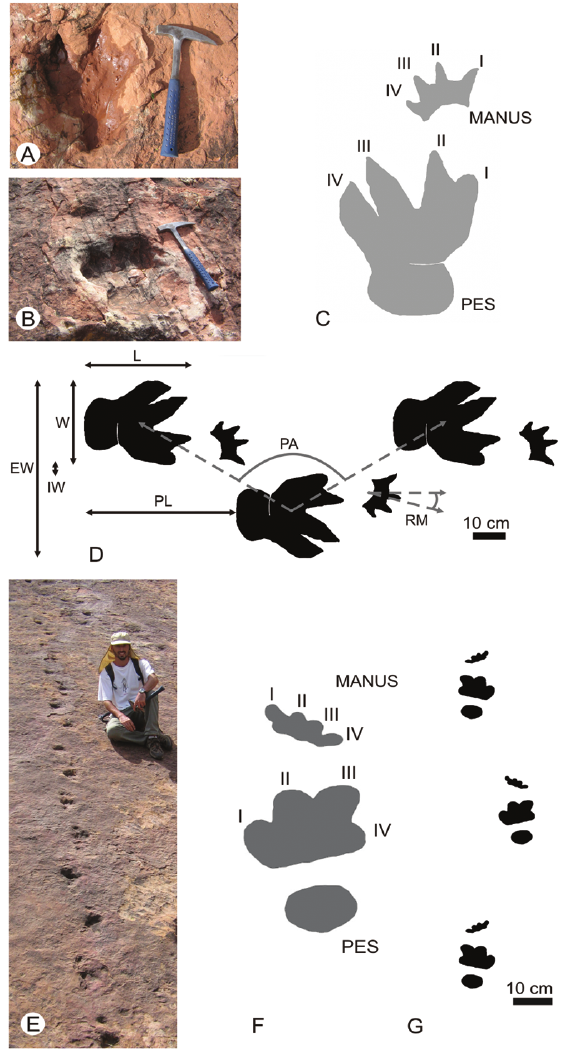
Fig. 2–IchnotaxaAandB.PesandmanusoftheIcnotaxonA(A,B,C), trackwayschemewithdistancespreservedandprincipalmeasurements taken (D). Ichnotaxon B trackways (E), track and trackway scheme (F, G).Abbreviations: EW,externaltrackwaywidth;IW,internaltrackway width; L, length; PA, pace angulation; PL, pace length; RM, rotation from midline; W,